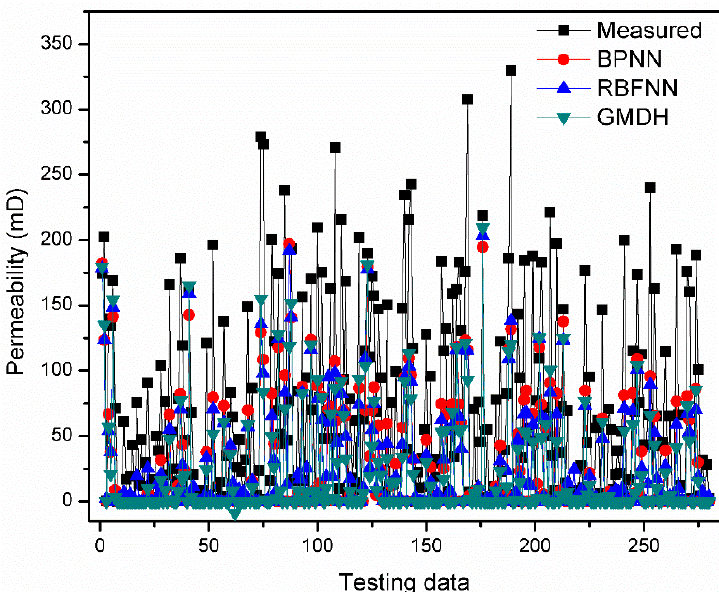
Figure 8. GMDH and ANN prediction in comparison with measured permeability data during training.